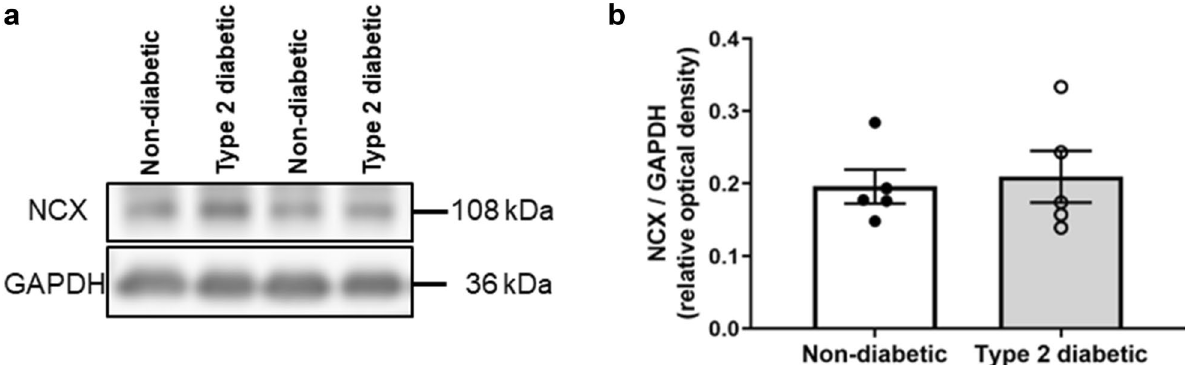
Figure 4. Protein expression of NCX in non-diabetic and diabetic rat left ventricular tissues. ( a ) Representative immunoblots of NCX and GAPDH. ( b ) Quantification of NCX levels in non-diabetic and diabetic hearts. Data shown are means ± SEM, obtained from duplicate blots, P > 0.05 versus non-diabetics, unpaired t-test. Original immunoblots are presented in Supplementary Fig S1.